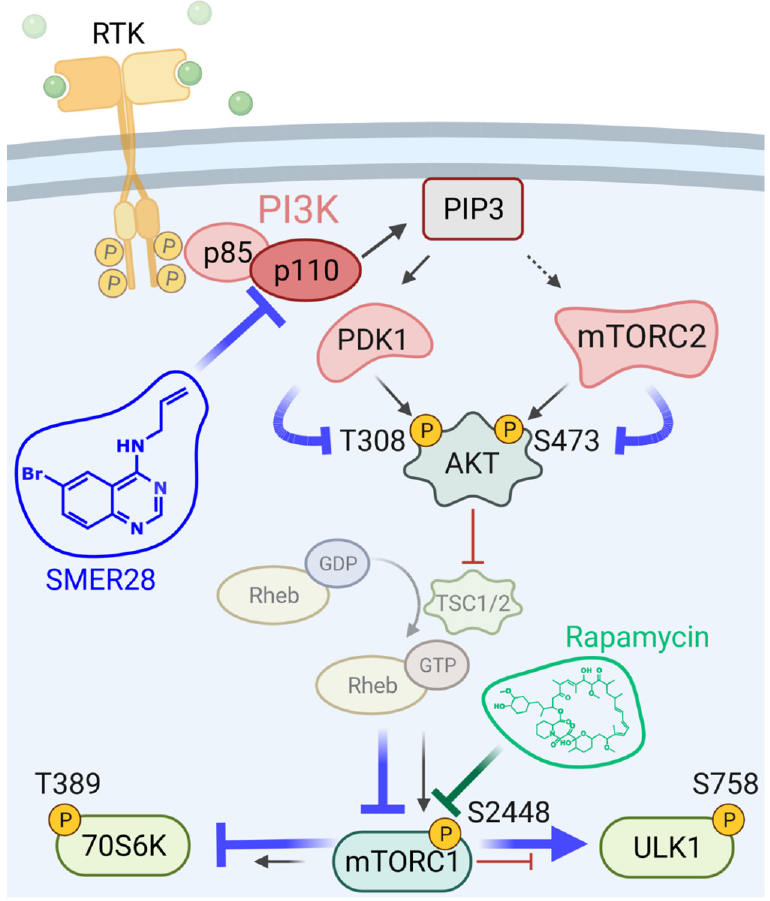
Figure 8. Scheme proposing the place of action of SMER28. Blue lines indicate the inhibitory (T) or stimulatory ( ↑ ) activity of